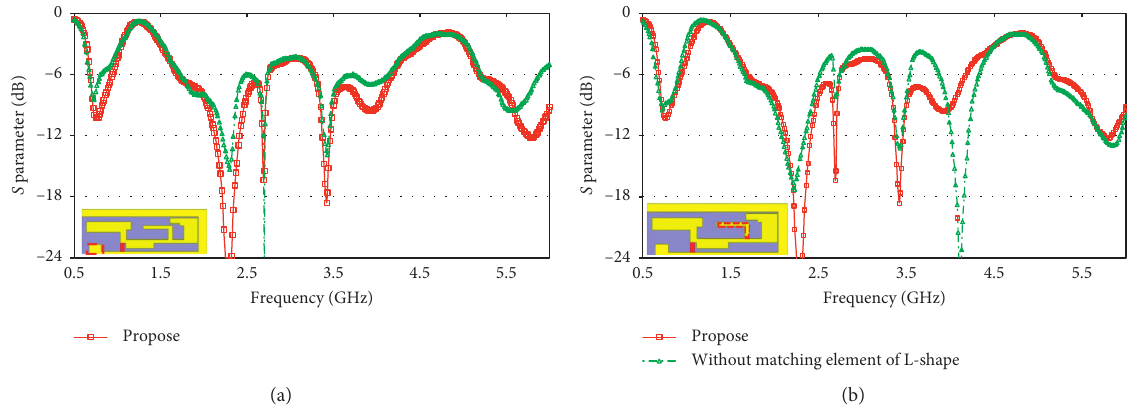
Figure 7: (a) S 11 values derived from simulation of developed antenna without and with a ground strip; (b) S 11 values derived from simulation of developed antenna without and with an inverted L-shaped matching